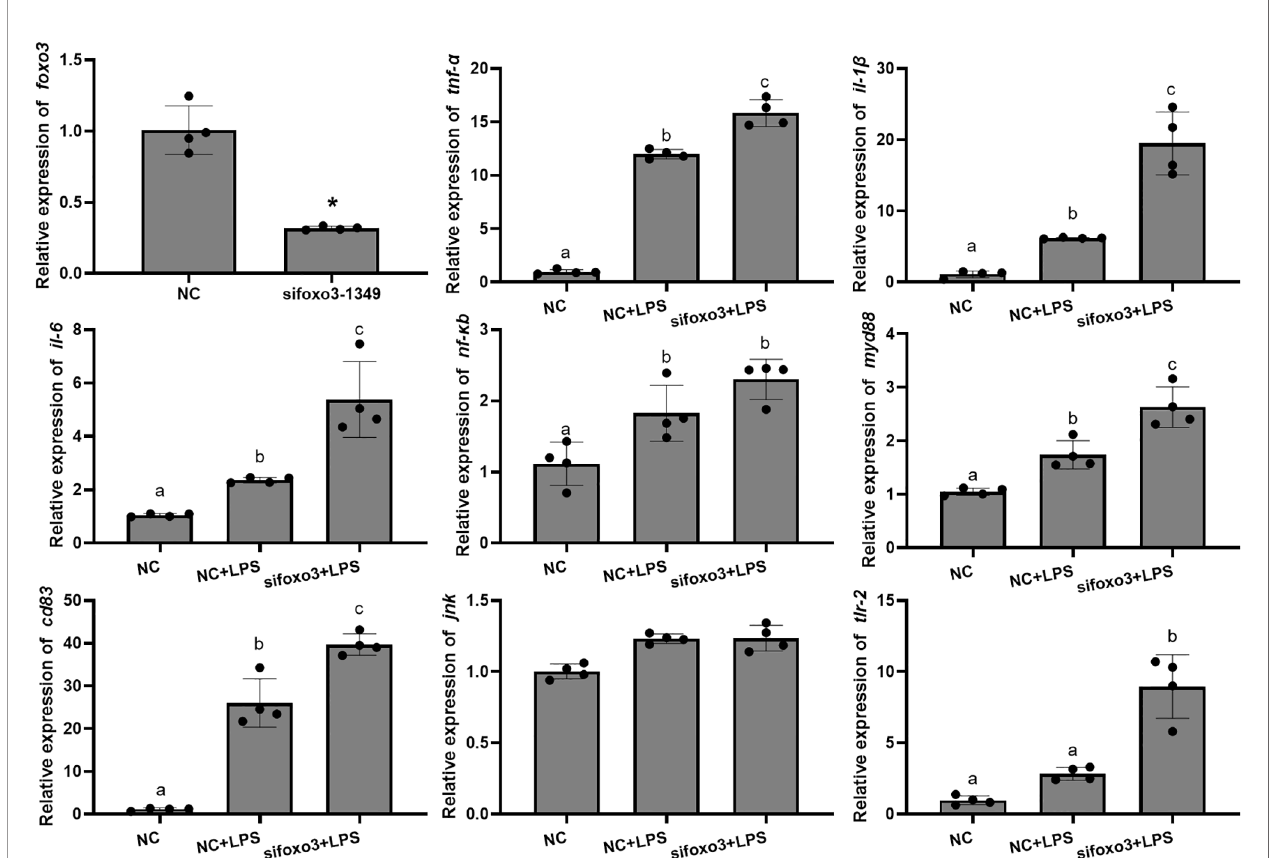
FIGURE 4 | Relative mRNA levels of foxo3 , tnf- a , il-1 b , il-6 , nf- k b , myd88 , cd83 , jnk and tlr-2 in primary hepatocytes of turbot. The results are expressed as the mean ± standard deviation (n = 4). ‘ * ’ means signi fi cantly different between two group ( P < 0.05). The different letters are signi fi cantly different ( P <